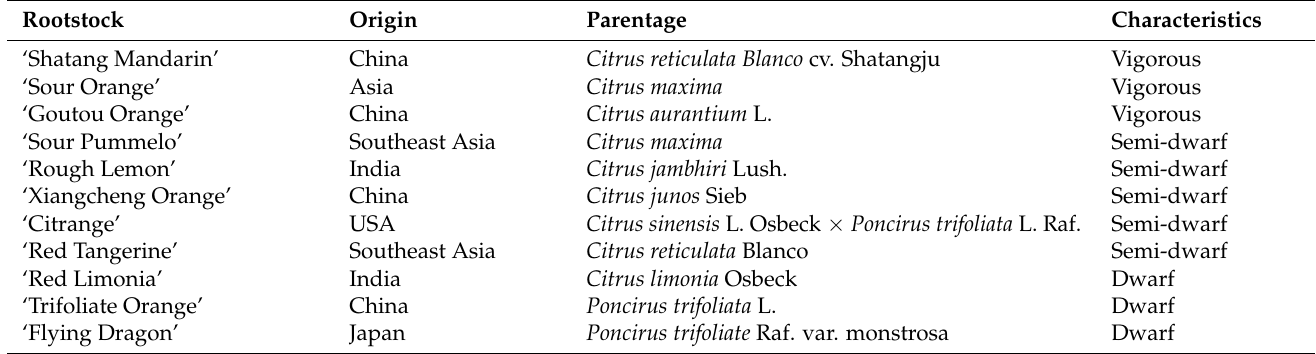
Table 1. The vigor, description, and origin of different rootstocks used in this study.